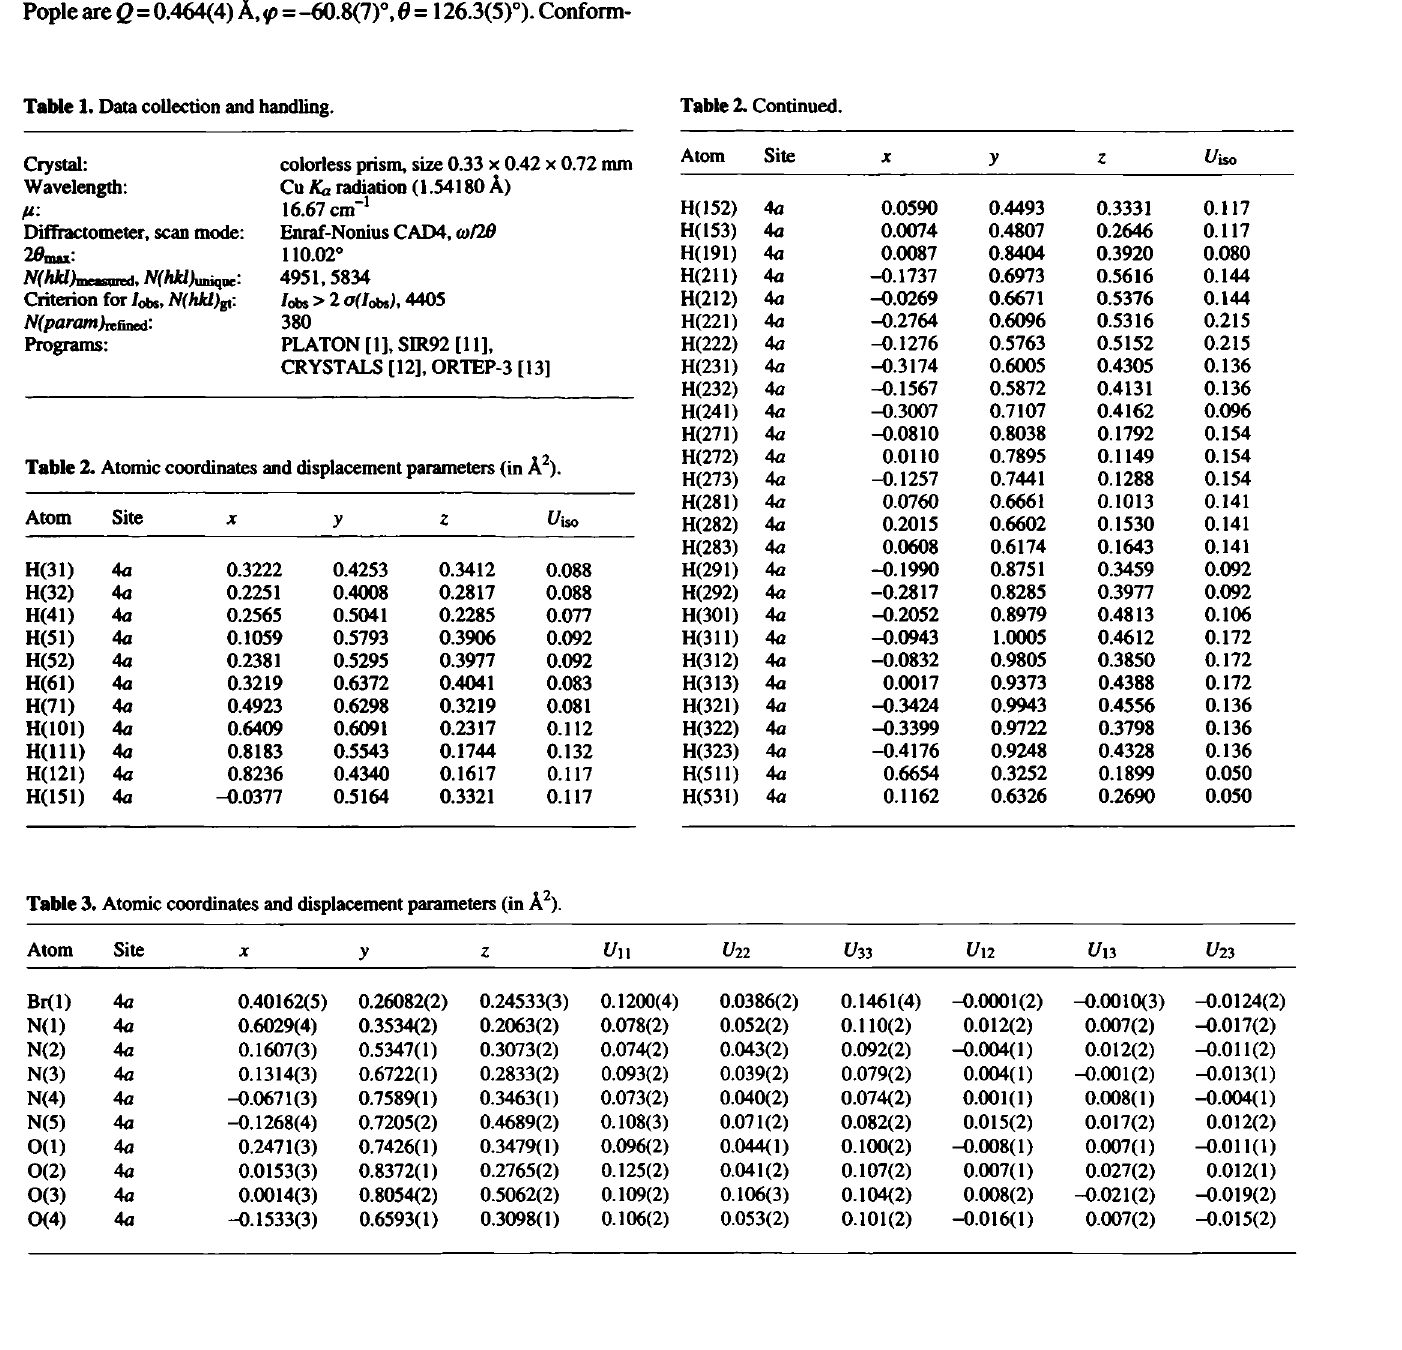
Table 2. Atomic coordinates and displacement parameters (in A 2 ).